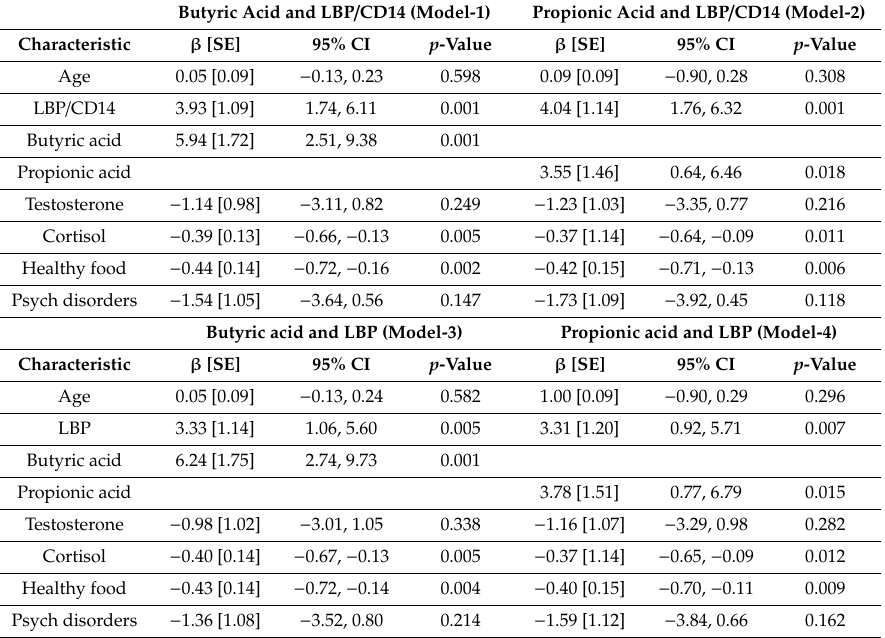
Table 3. Models presenting significant determinants for Body mass index